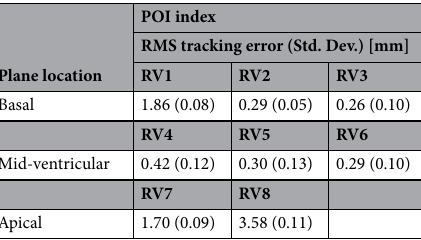
Table 3. RMS tracking errors of the numerical phantom data for the 8-point RV model.